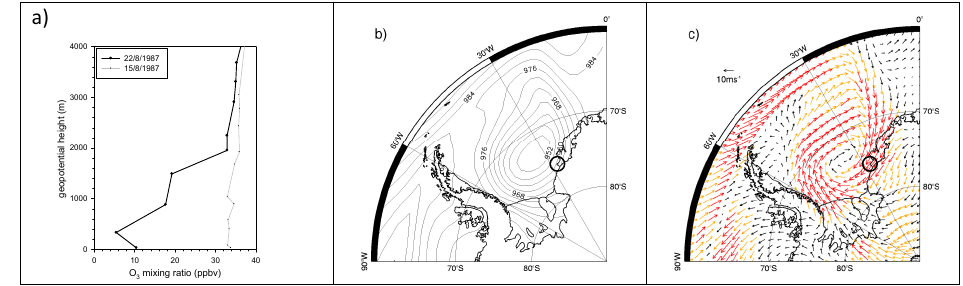
Fig. 11. (a) Ozonesonde measurements on 22 August 1987 compared with an un-depleted profile for the middle of the same month; (b) mean sea level pressure on 21 August 1987 (noon); (c) 10-m wind vectors on 21 August 1987 (noon) – wind speeds identified as: black = < 8ms − 1 ; orange = 8 to 12ms − 1 ; red = > 12ms − 1 . Halley is marked by the black circle on the